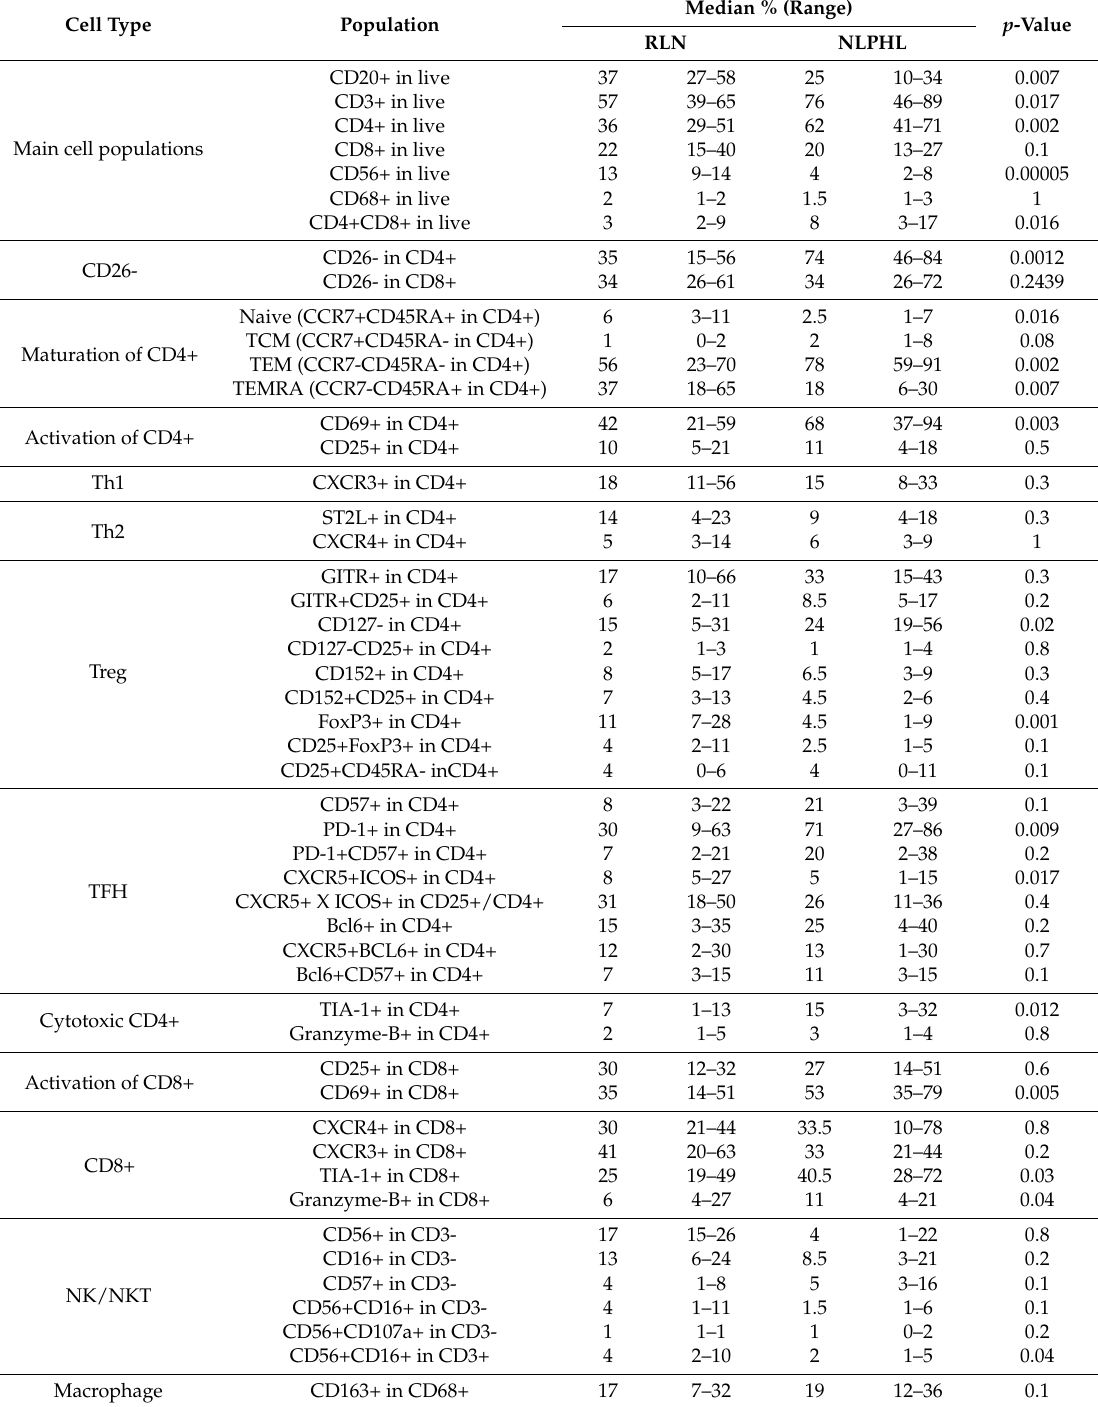
Table 1. Median percentages of cell populations analyzed in NLPHL and